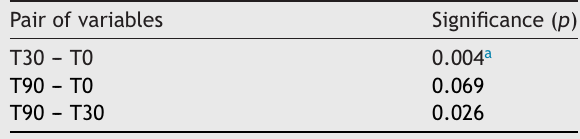
Harmonic---noise ratio (HNR) --- Vowel